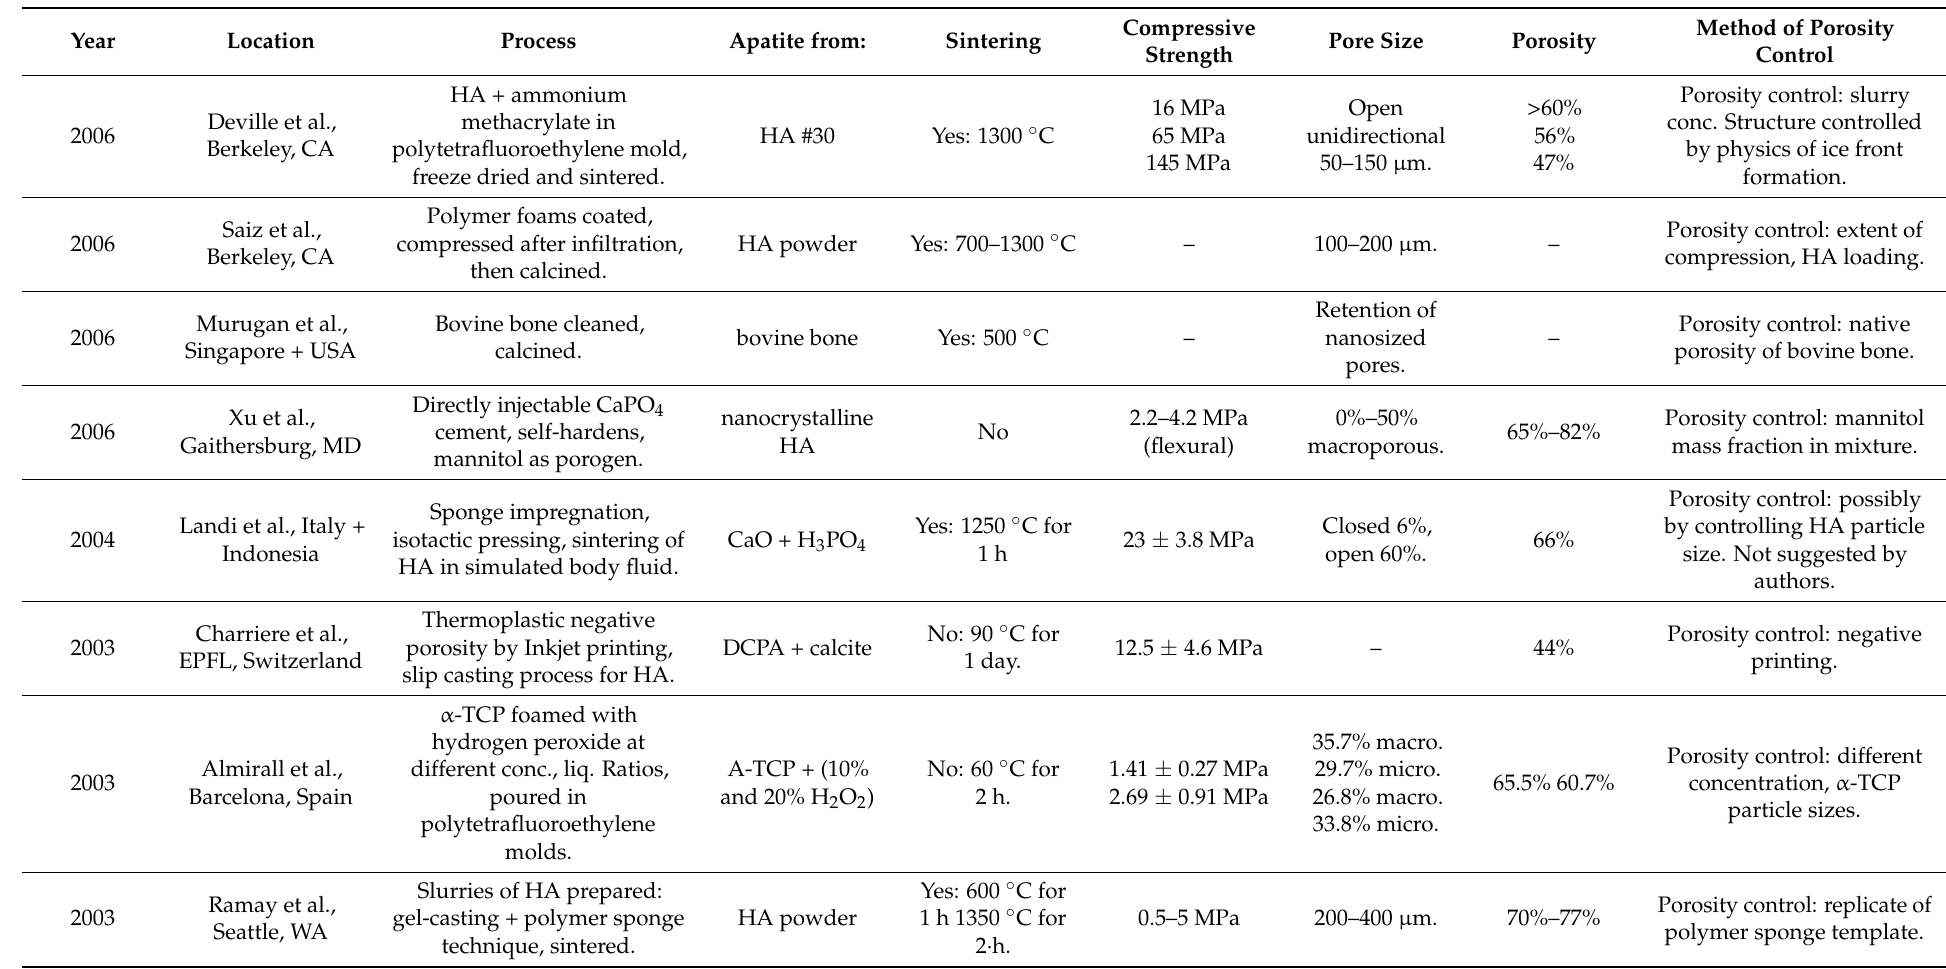
Table 2. The procedures used to manufacture porous CaPO 4 scaffolds for tissue engineering